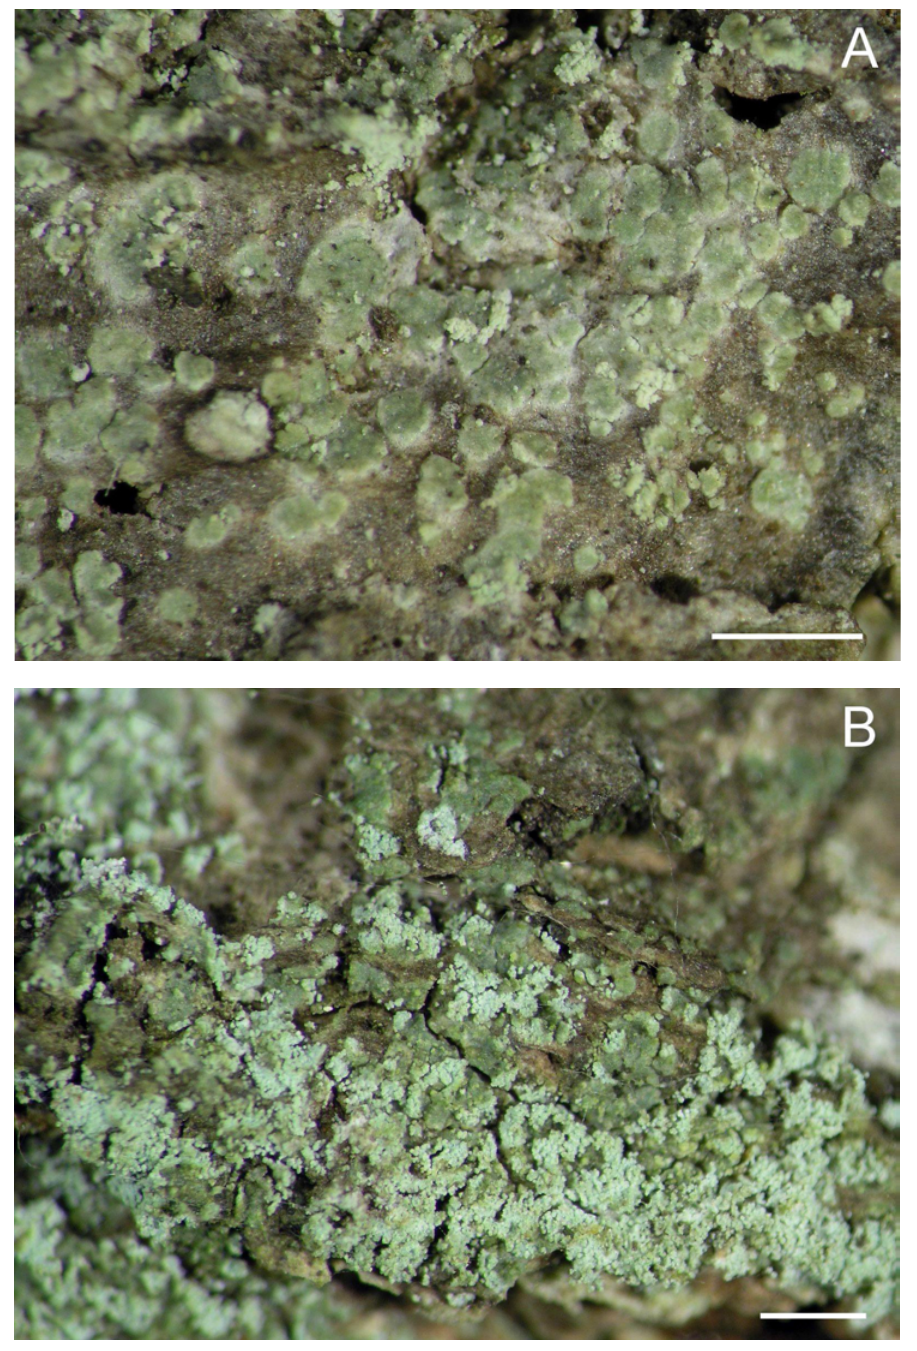
Fig. 2. Rinodina degeliana : A – areolate thallus with few marginal soralia OLTC L-3296; B – thallus with numerous scattered soralia OLTC L-3297. Scale bars = 1